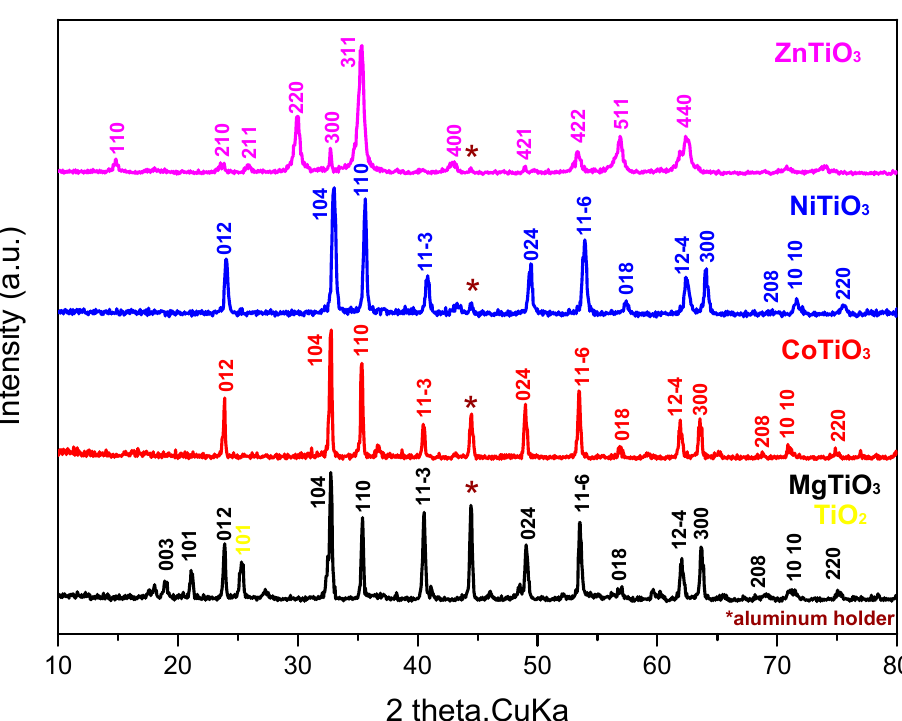
Figure 2. XRD patterns of metal titanate nanorods ATiO 3 (A = Mg, Co, Ni, Zn) after annealing process. The lattice parameters of all the samples were in good agreement with the theoretical ones (Table 1). However, a deviation is observed because each sample’s metal in A-site has different ionic radii. Lattice parameters and volume cell of NiTiO 3 are smaller than MgTiO 3 which is smaller than CoTiO 3 . Moreover, Mg 2+ has a radius of 0.72 Å [61,62] and Ni 2+ 0.69 Å [63] thus the lattice parameters in NiTiO 3 are smaller than those of MgTiO 3 . With the same notion, Co 2+ radius is 0.74 Å [64] (larger than the radius of Mg 2+ ) so the lattice parameters of CoTiO 3 are larger than those of MgTiO 3 . Following the same trend as the lattice parameters the volume of NiTiO 3 cell is the smallest, the volume of CoTiO 3 cell is the highest, and the volume cell of MgTiO 3 is in-between. The volume cell of ZnTiO 3 is the smallest of all the four samples because it crystallizes in cubic system. The crystalline size too, follows the same trend as cell volume and lattice parameters. More specifically, NiTiO 3 crystalline size is the smallest, MgTiO 3 has slightly bigger crystalline size, and CoTiO 3 has the highest. The ideal perovskite structure is in cubic lattice (0.9 < t < 1). Mixed oxides with t lower than 0.8 crystallize in ilmenite structure, a distortion from perovskite structure where A and Ti cations occupy octahedron sites. The tolerance factor for NiTiO 3 , MgTiO 3 , and CoTiO 3 is found to be 0.73, 0.75, and 0.76, accordingly. So, because the values below the ilmenite barrier, the samples correspond to ilmenite structure. The tolerance factor for ZnTiO 3 is found to be 0.99 and corresponds to cubic structure. All values are in good agreement with the structural analysis and the theoretical